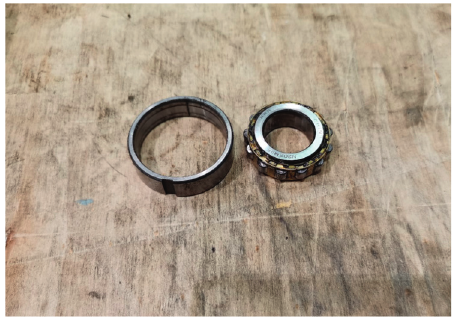
Figure 14: Outer ring fault bearing used in the